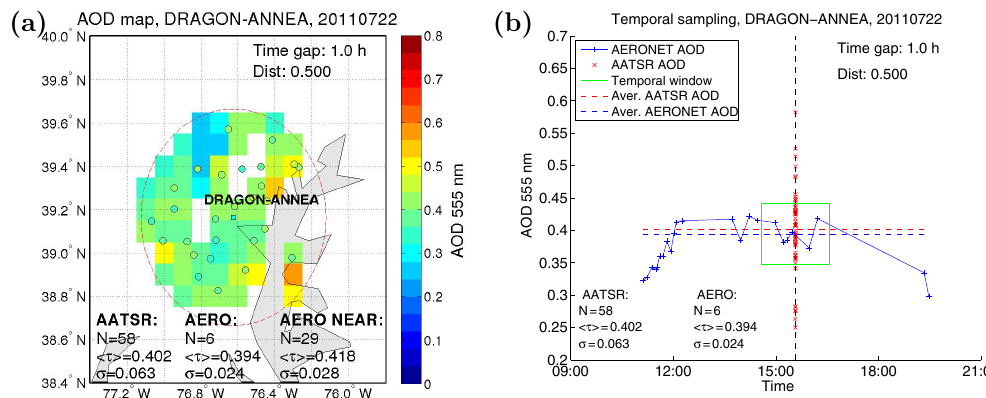
Figure 2. (a) Spatial sampling in the AOD comparison. The dashed red circle shows the sampling area around an AERONET site (DRAGON_ANNEA, colored square). The colored boxes show the AOD values for AATSR pixels for the example scene (22 July 2011). The colored symbols show the AOD values of the other AERONET sites within the sampling area. The text inset at the bottom of the im- age shows the number of samples, average AOD, and the standard deviation for AATSR, the central AERONET site, and for the nearby AERONET sites. (b) Temporal sampling in the AOD comparison. The green rectangle indicates the temporal sampling window. The blue line and symbols show the AERONET observations for the selected site as function of time (UTC), while the red symbols show the AATSR AOD values at the overpass time. The dashed horizontal lines show the averaged AOD values for AATSR (red) and AERONET (blue) using the selected sampling parameters ( d = 0 . 5 ◦ , (cid:49)t = 1h). See Sect. 3.2 for more details.